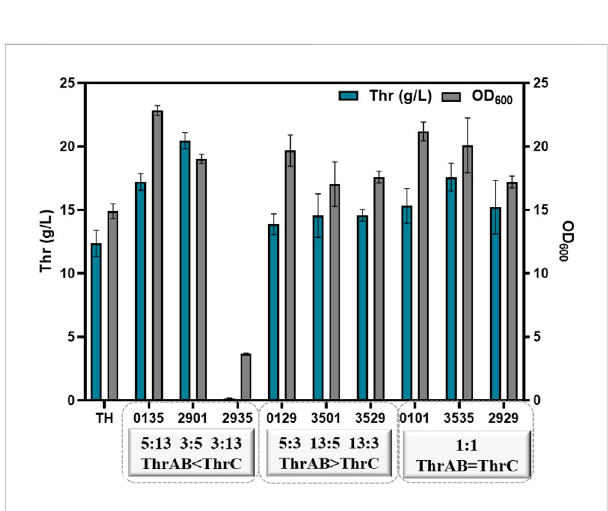
The effectofdifferentexpressionintensities of thrAB and thrC on L-threonine production by the TH strain. All results were derived from three ( n = 3) independent